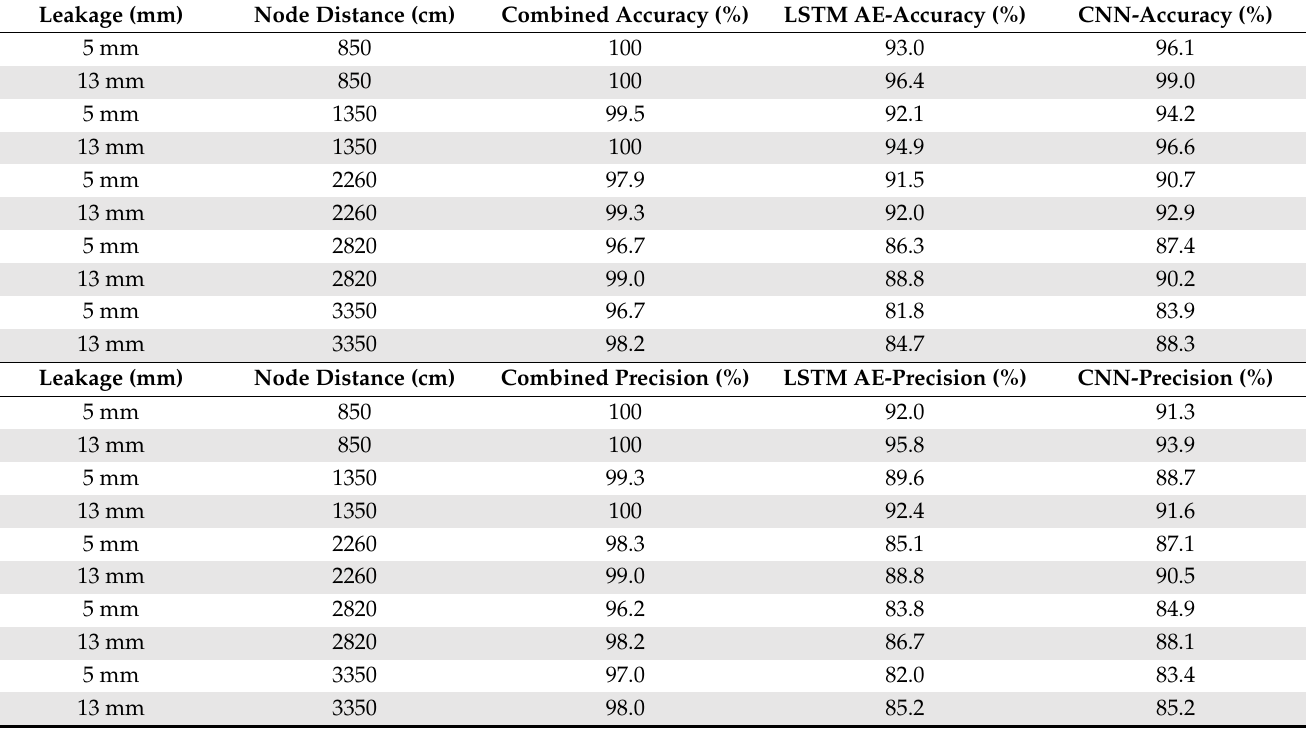
(b) LSTM AE, (c) CNN